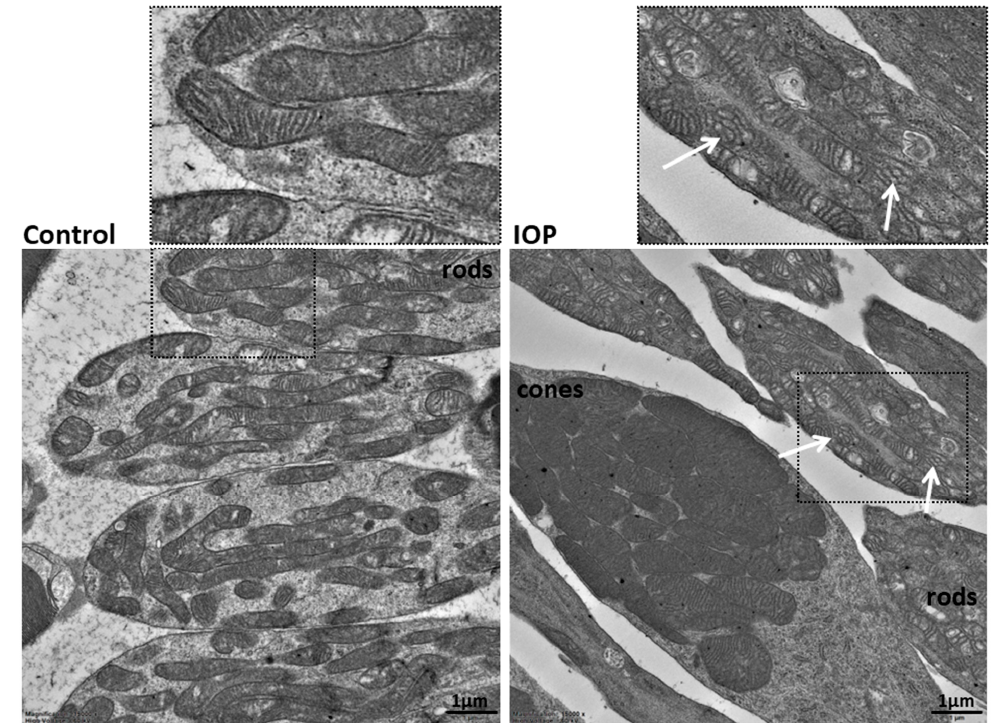
Figure 2. Ultrastructural features of the mitochondria in the rods of the retinal ischemia-induced ( right image) and control ( left image) eye. The cristae of the mitochondria are compact and narrow in the control eye. White arrows show the presence of dilated cristae with abnormal shapes in the mitochondria of the high-pressure-induced retinal ischemia model. Two ultrathin sections of the neuroretina were observed, 64 RI cells and 56 control cells were used to evaluate the mitochondrial phenotype in rods, and the phenotype appeared homogeneous throughout the sample. TEM, 15,000×.